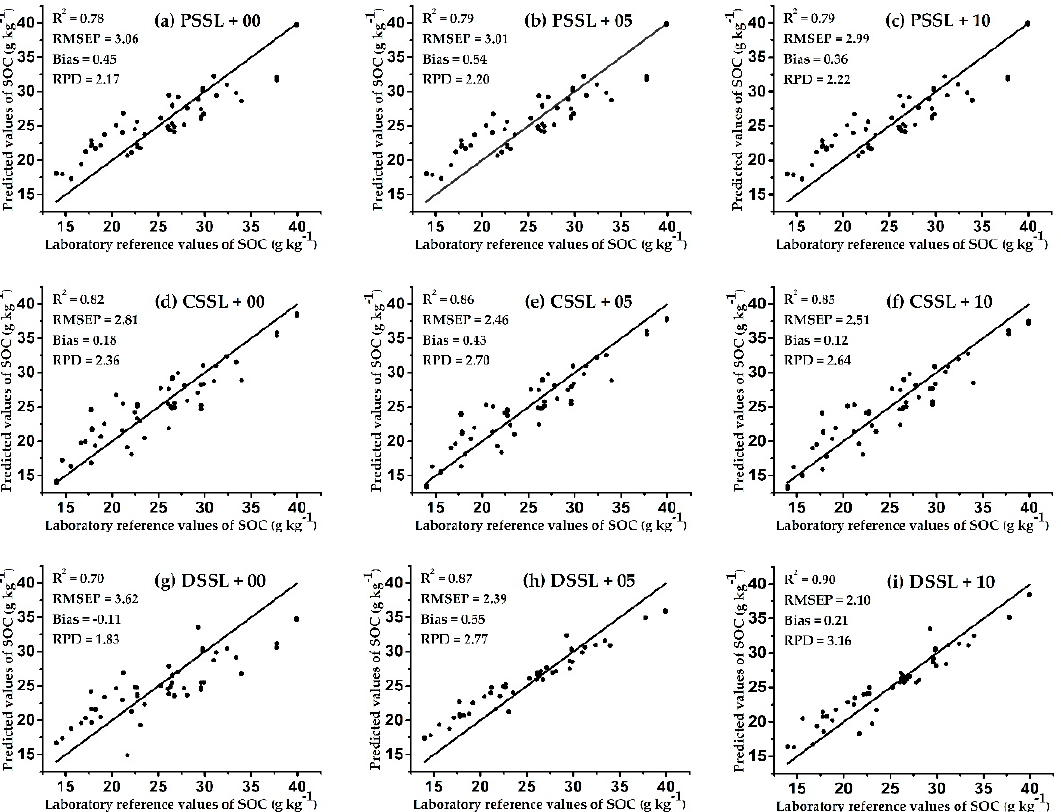
Figure 5. Scatter plots of predicted values and laboratory reference values of SOC of TA2 pre by each model. Scatter plots ( a , d , g ) show the prediction e ff ect of the UMs; ( b , e , h ) show the SMs with 5 spiking samples from the target area; and ( c , f , i ) show the SMs with 10 spiking samples from the target